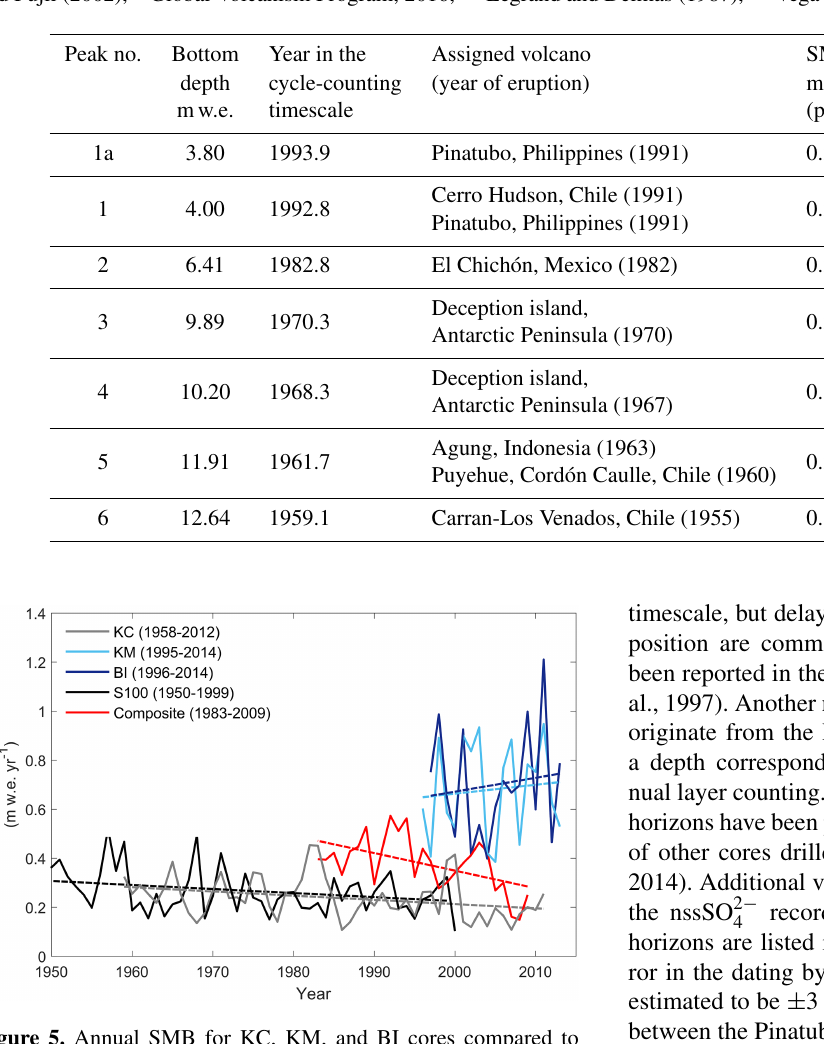
Table 3. Volcanic eruptions inferred from the KC nssSO 2 − concentrations. Only volcanoes with a volcanic explosivity index ≥ 3 were 4 considered. The SMB rate was obtained using the timescale obtained by δ 18 O cycles counting. Ref.: 1 Karlöf et al. (2000), 2 Palmer et al. (2001), 3 Nishio et al. (2002), 4 Stenni et al. (2002), 5 Zhang et al. (2002), 6 Cole-Dai et al. (1997), 7 Dibb and Whitlow (1996), 8 Kohno and Fujii (2002), 9 Global Volcanism Program, 2016, 10 Legrand and Delmas (1987), 11 Vega (2008), 12 Kaczmarska et al. (2004).